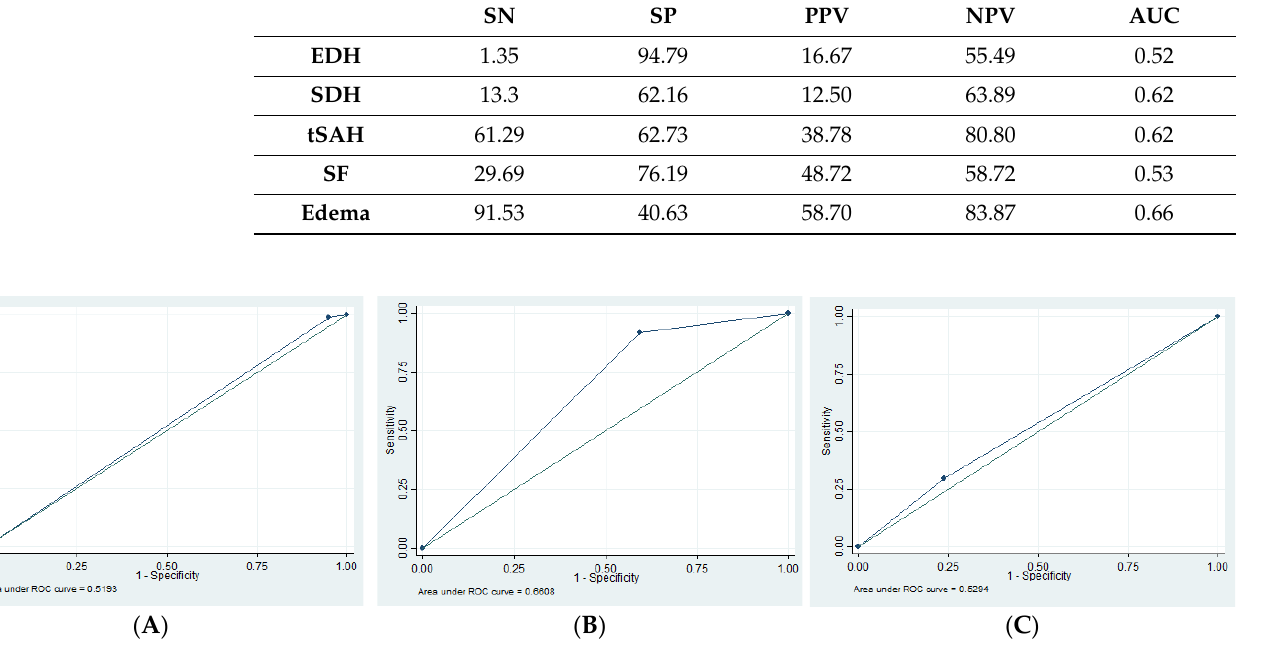
Table 3. Sensitivity (SN), specificity (SP), negative predictive value (NPV), positive predictive value (PPV), and area under the curve (AUC) for epidural hematoma (EDH), subdural hematoma (SDH), traumatic subarachnoid hemorrhage (tSAH), skull fractures (SF), and edema.